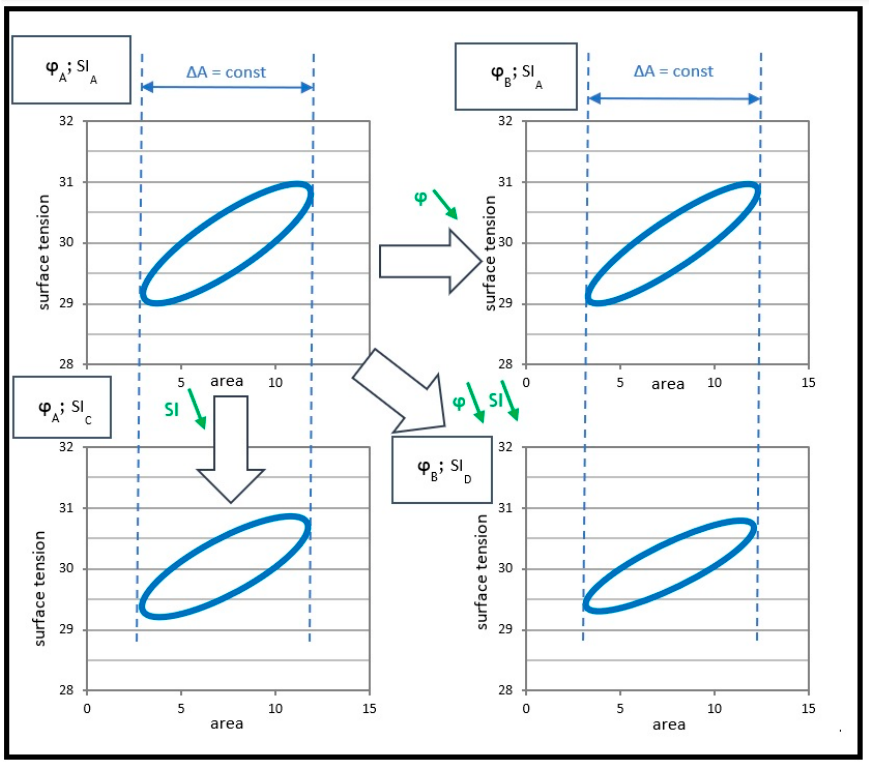
Figure 5. Theoretical analysis of the relationship between various numerical parameters describing σ –A hysteresis in an MPS system and their influence on the hysteresis shape and size.